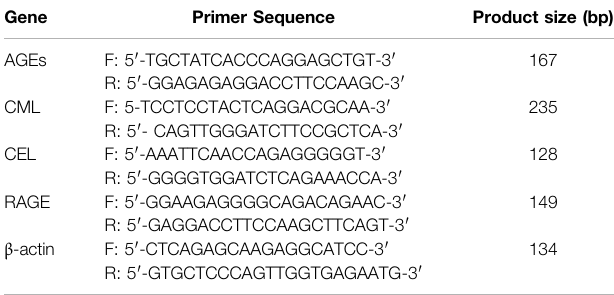
TABLE 1 | Real-time PCR primer sequences. Gene Primer Sequence Product size